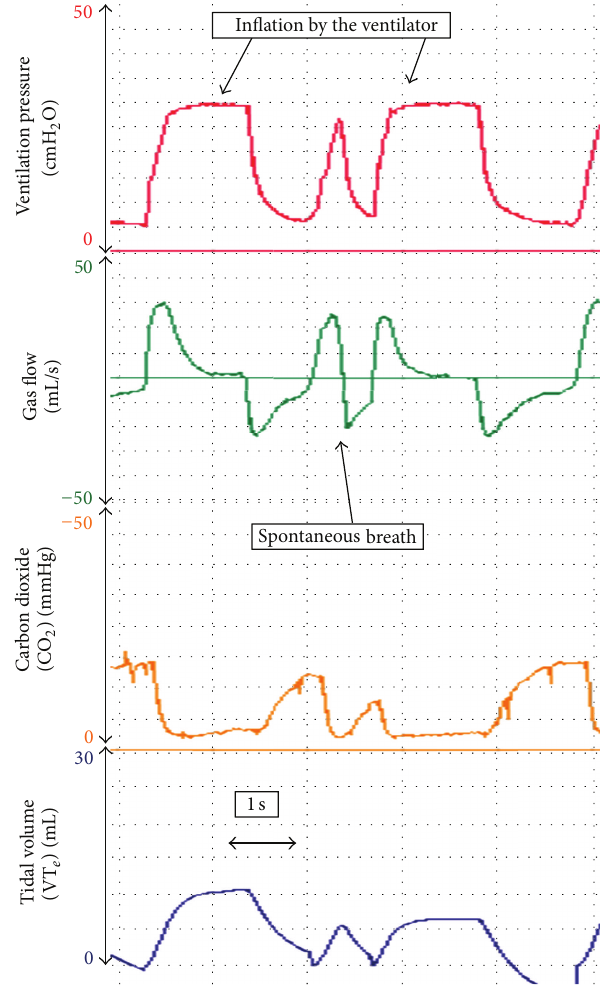
Figure 6: During manual inflations the infant is taking a sponta- neous